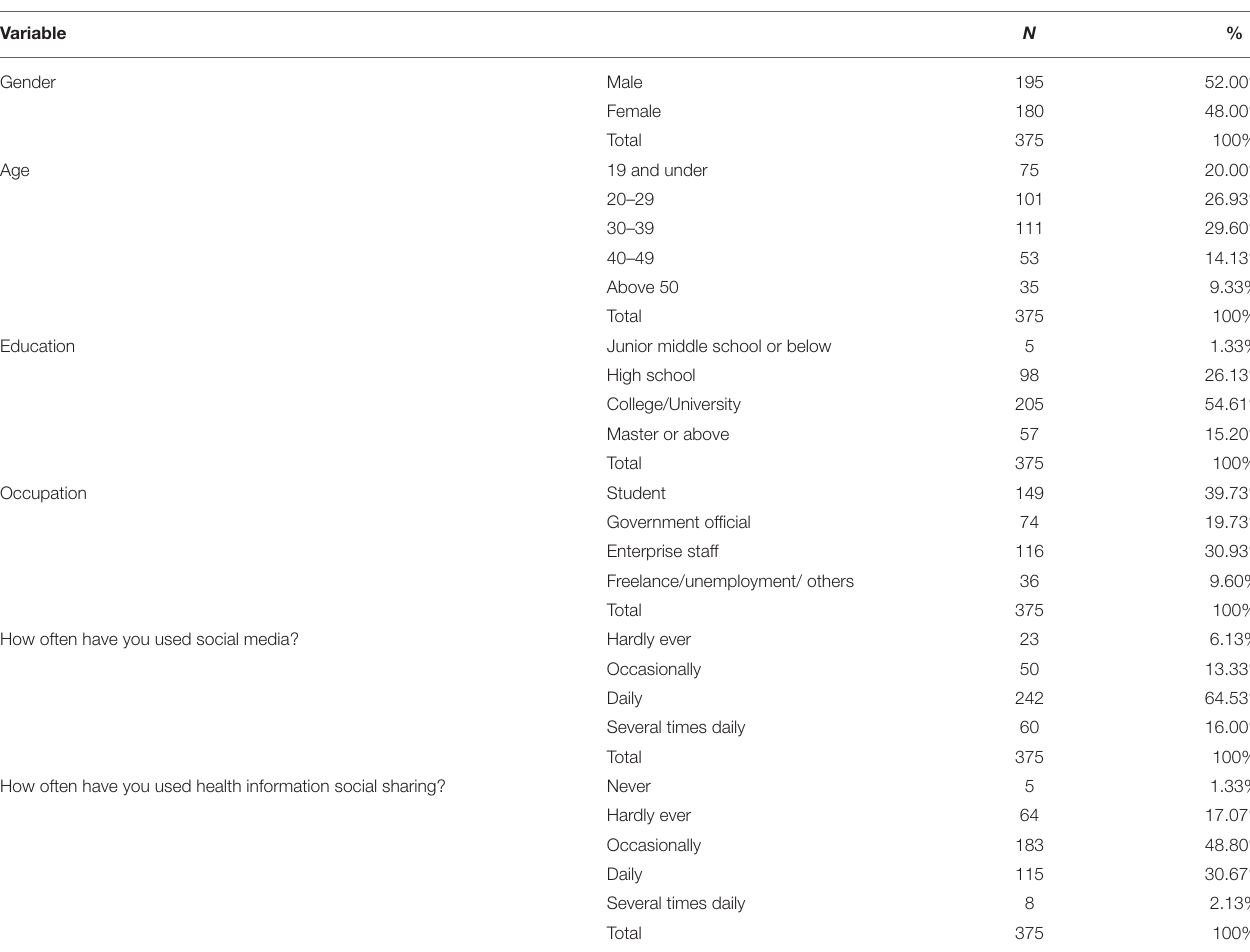
TABLE 1 | Participant